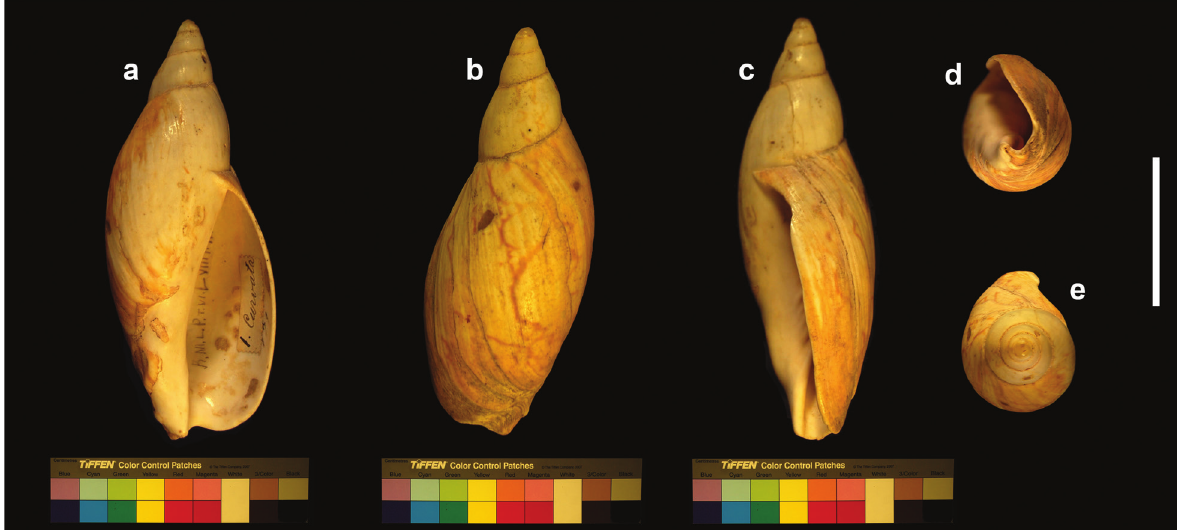
Figure 12. Voluta ancilla ponderosa , specimen figured by Lahille (1895: pl. VIII, fig. 171), shell reads “ curvata ”. a Apertural view b Dorsal view c Lateral view d Umbilical view e Apical view. Scale bar: 5 cm.